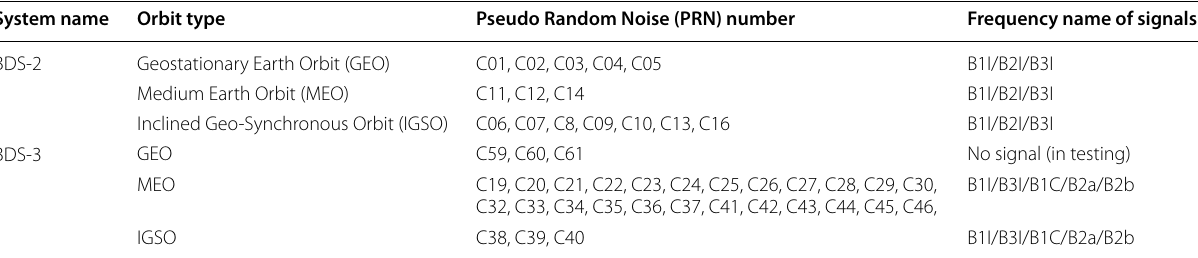
Table 1 Operation of BDS satellites in